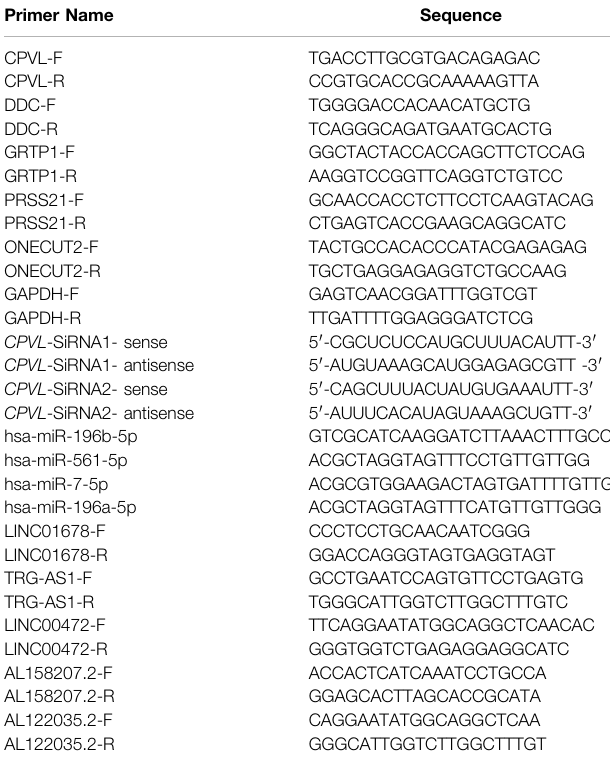
TABLE 1 | List of the primers used in the